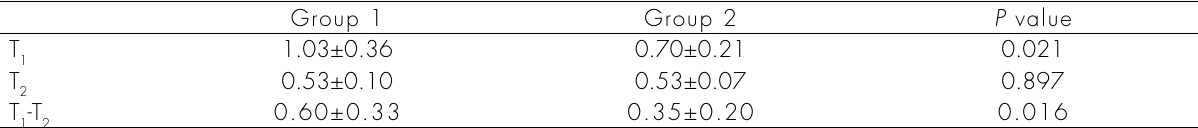
Table V. Inter group comparison between the mean surface roughness measurements at T1 and T2 for Groups 1 and 2 (N = 16)( p < 0.05).